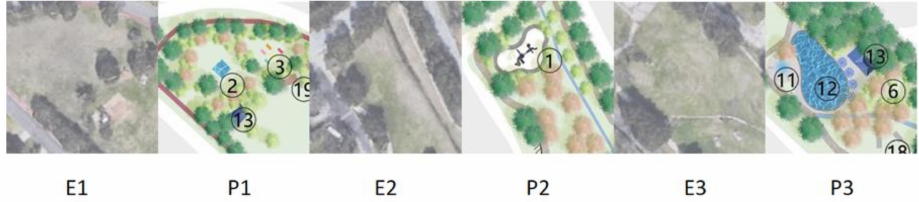
Figure 4. Selected simulation locations on the